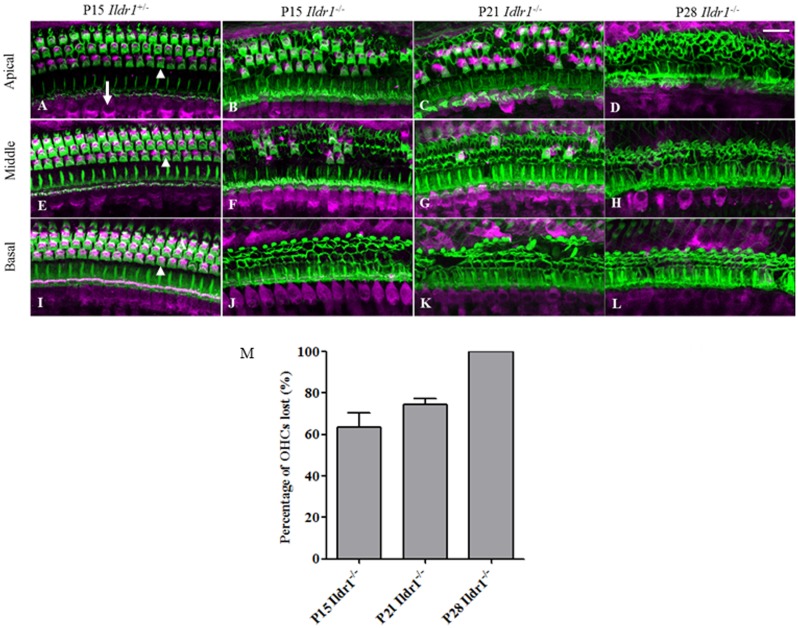
Hair cells in the organ of Corti labeled with myosin 7a antibody (magenta) and counterstained with phalloidin labeling of cytoskeletal filamentous actin (green) in P15, P21, and P28 mice.Hair cells in the apical (A–D), middle (E–H), and basal turns (I–L) of the cochlea are shown separately. (M) Histograms showing the percentage of outer hair cells degenerated in P15, P21, and P28 Ildr1−/− mice. Arrowhead in A points to the outer hair cells (OHCs) and arrow in A points to the inner hair cells (IHCs). Scale bar: 20 µm.